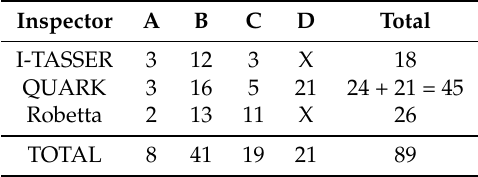
Table 5. Usability problems found in the heuristic